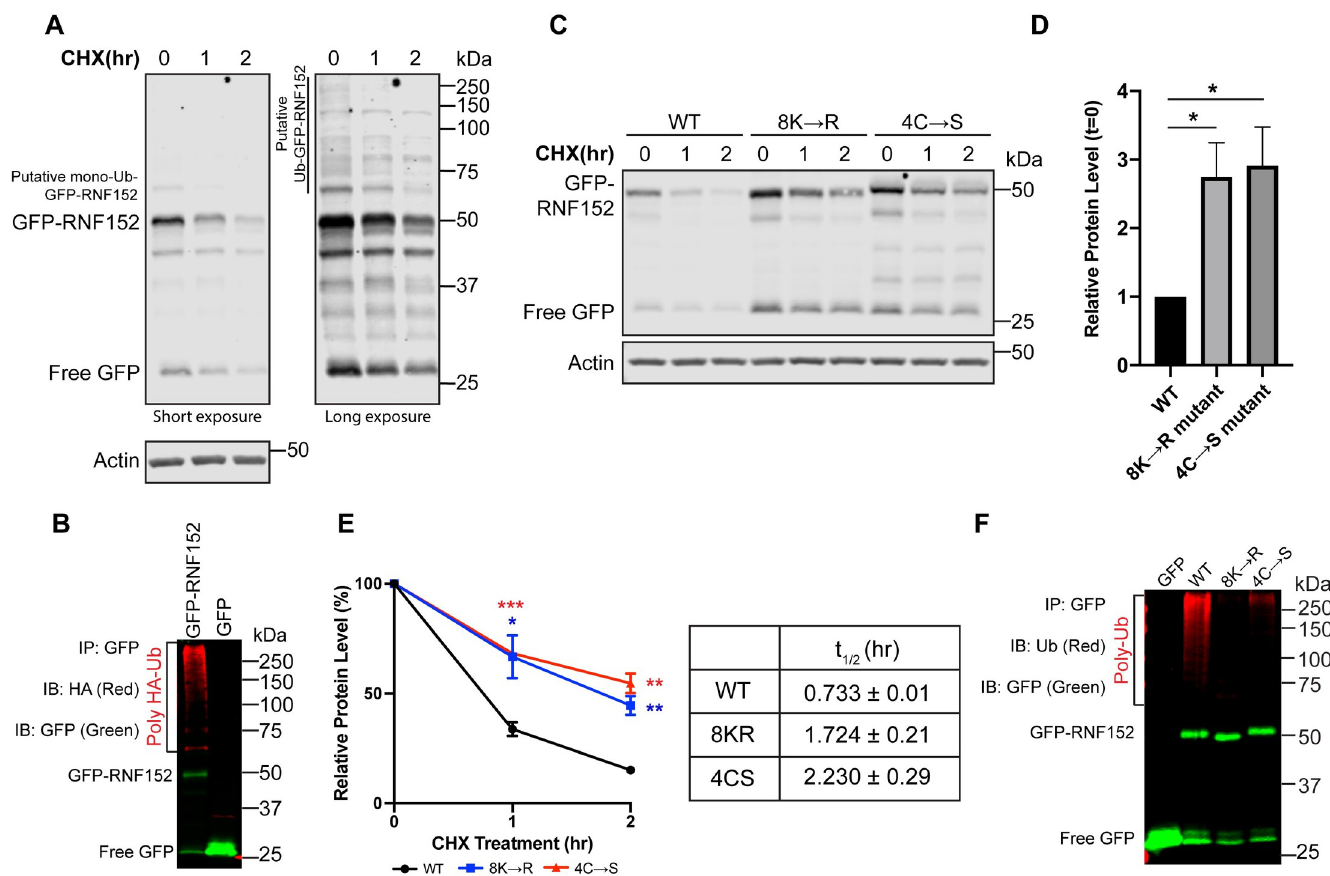
Fig 3. RNF152 degradation is ubiquitin dependent. (A) Left: CHX chase assay of stably expressed GFP-RNF152. Right: long exposure. (B) GFP-RNF152, but not free GFP, is polyubiquitinated. (C) CHX chase assay of stably expressed WT, 8K ! R, and 4C ! S mutants of GFP-RNF152. (D) Steady-state (0 hour) full-length protein levels in C, n = 3. Error bars represent standard deviation. � p � 0.05. (E) Left: quantification of GFP-RNF152 degradation in C, n = 3. Error bars represent standard deviation. � p � 0.05, �� p � 0.01, ��� p � 0.001. Table: Calculated protein half-lives. (F) 8K ! R and 4C ! S mutants have impaired polyubiquitination. Uncropped western blots are provided in S1 Raw Images. The numerical data underlying the plot can be found in S1 Data. CHX, cycloheximide; WT,